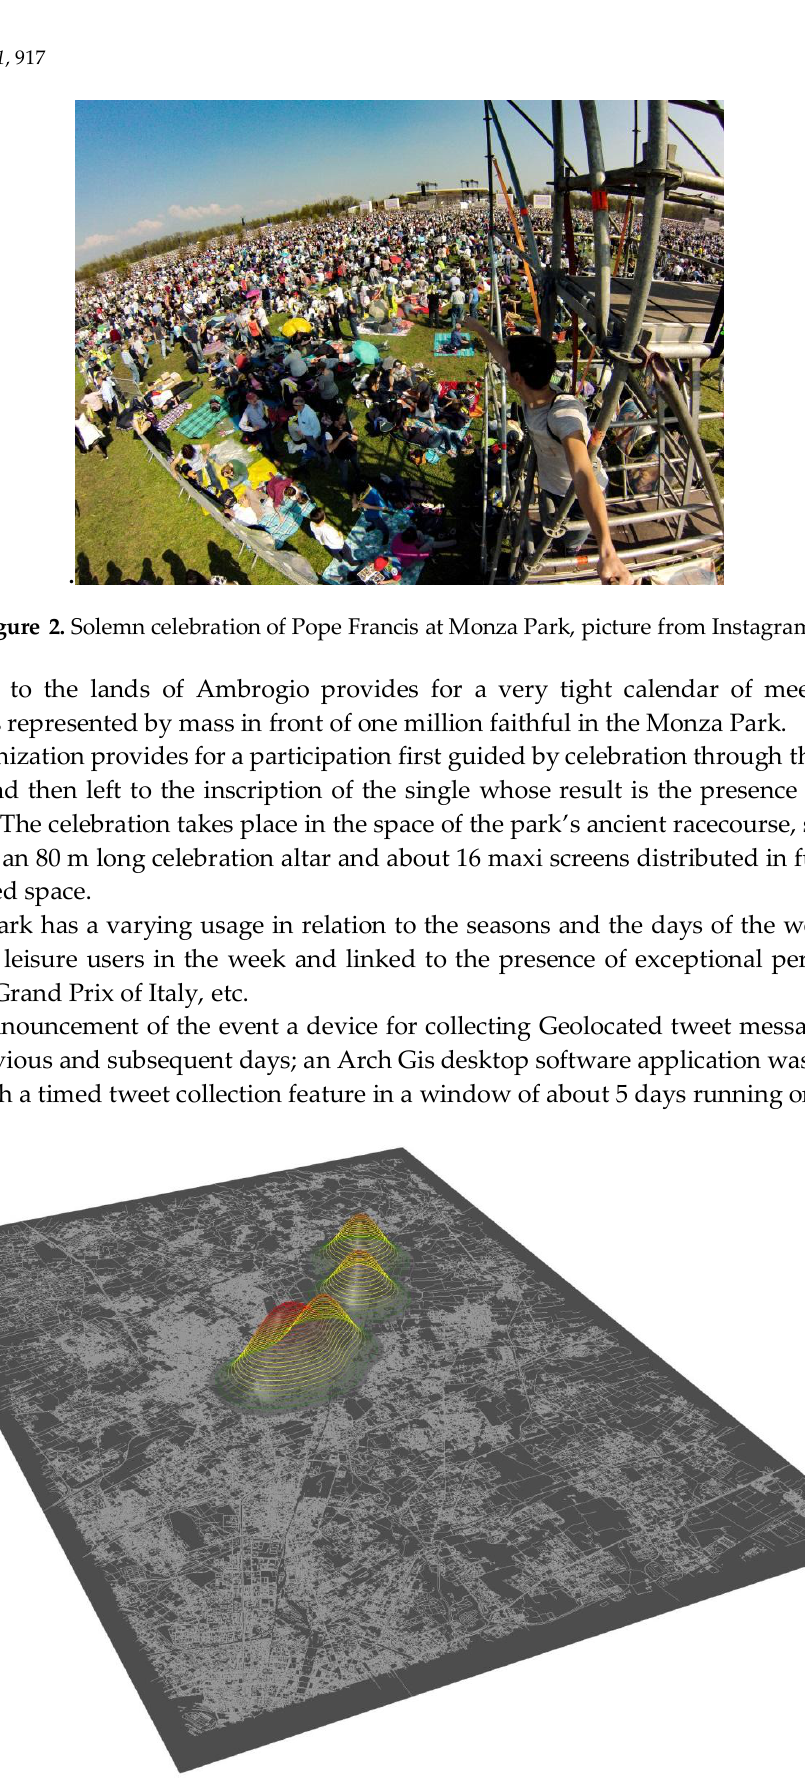
Figure 3. Tweets mapping dated 23rd